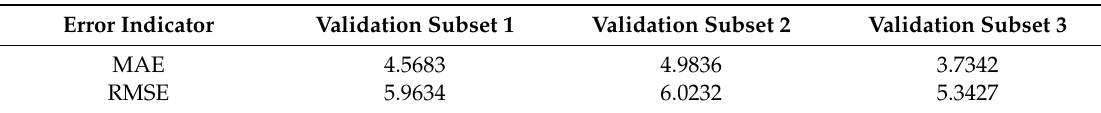
Table 2. Error indicator of the validation results. Mean absolute error, MAE; root mean squared error,